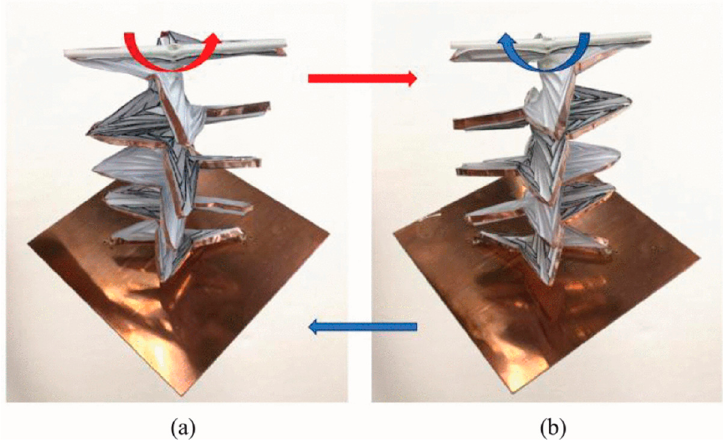
Figure 7. The prototype of the bifilar segmented helical antennas at ( a ) left-handed and ( b ) right-handed angles [103].